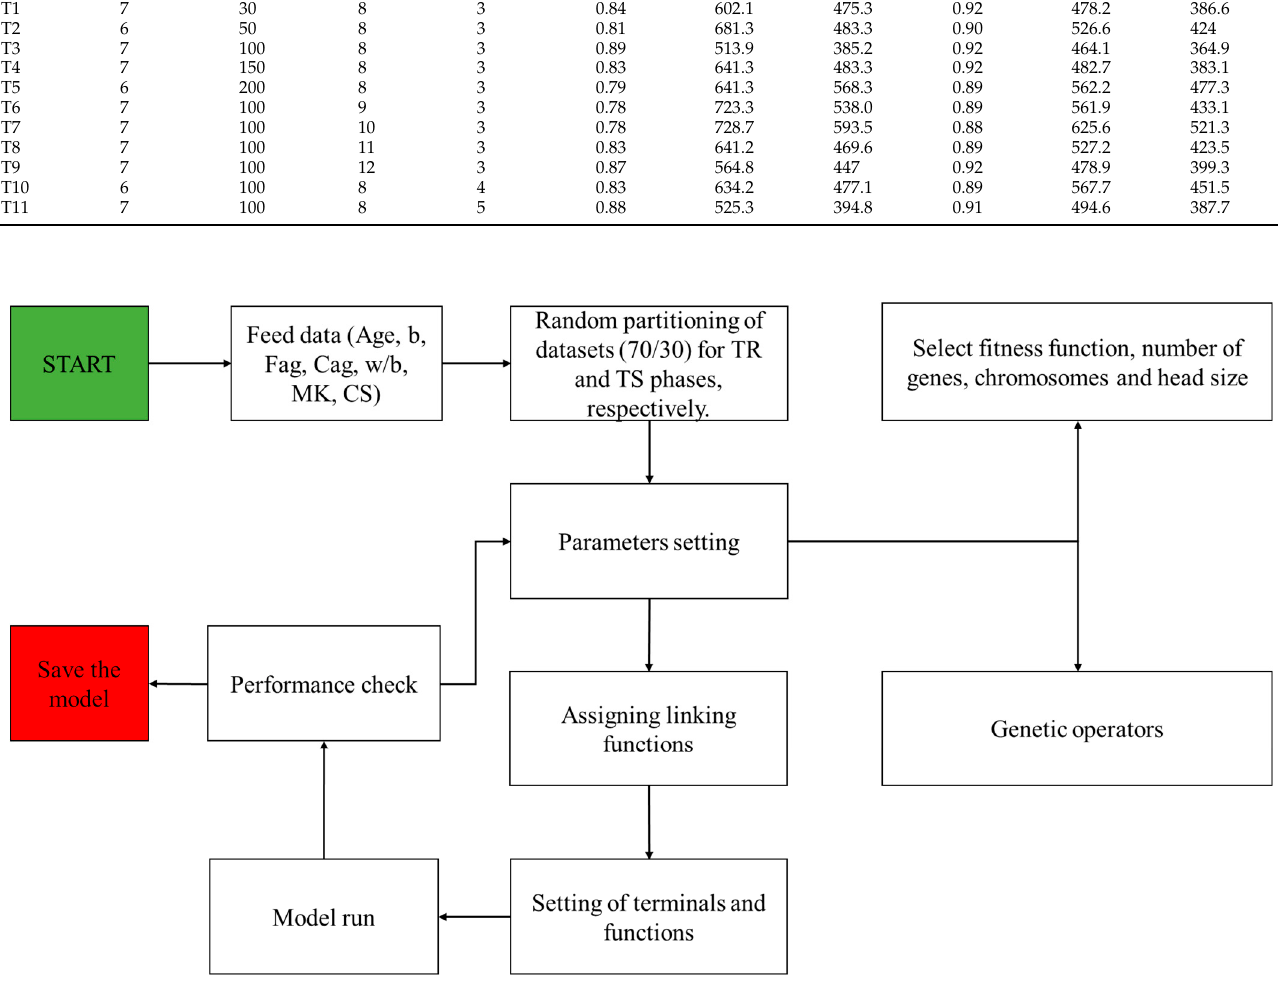
Figure 2. Flowchart of GEP modelling.